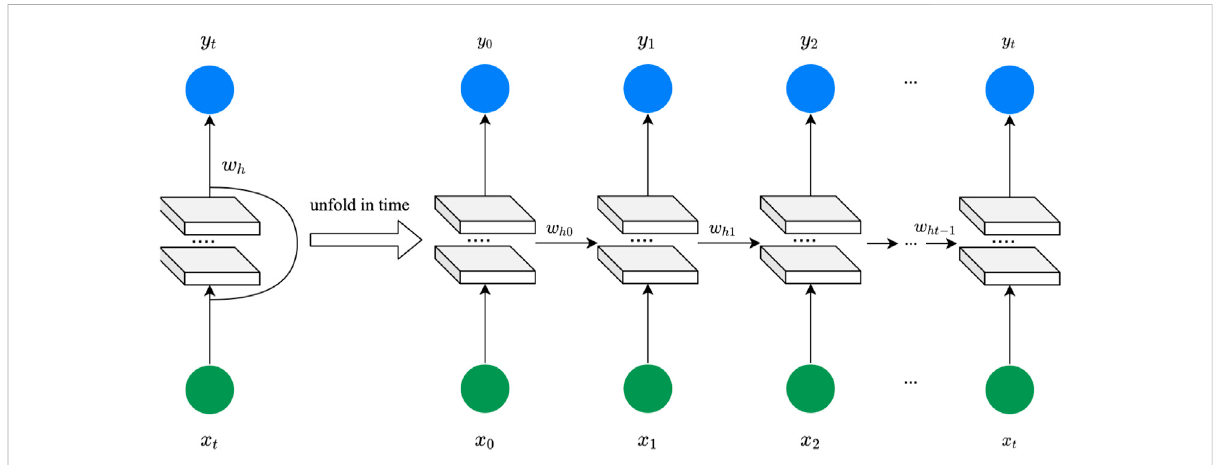
FIGURE 3 RNN model structure.